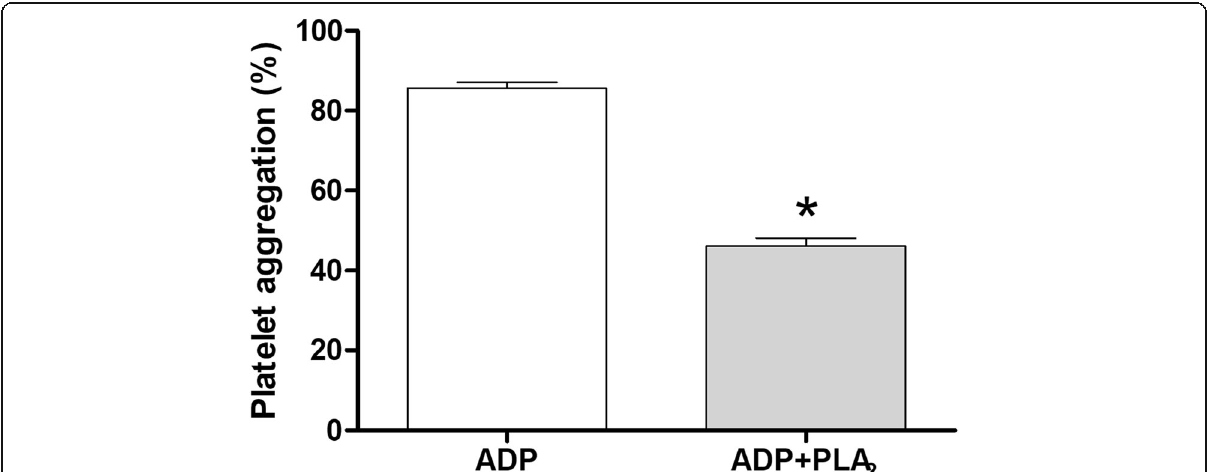
Fig. 6 Inhibition of platelet aggregation by BJ-PLA 2 -I. Initially, platelet-rich plasma (PRP) was incubated at 37 °C with ADP (5 μ M) for 10 min to determine the percentage of platelet aggregation. Next, PRP was first incubated at 37 °C with BJ-PLA 2 -I (20.5 μ g/mL) for 5 min, followed by addition of ADP (5 μ M) and evaluation for another 10 min to determine the inhibition promoted by the toxin. Results were expressed as mean